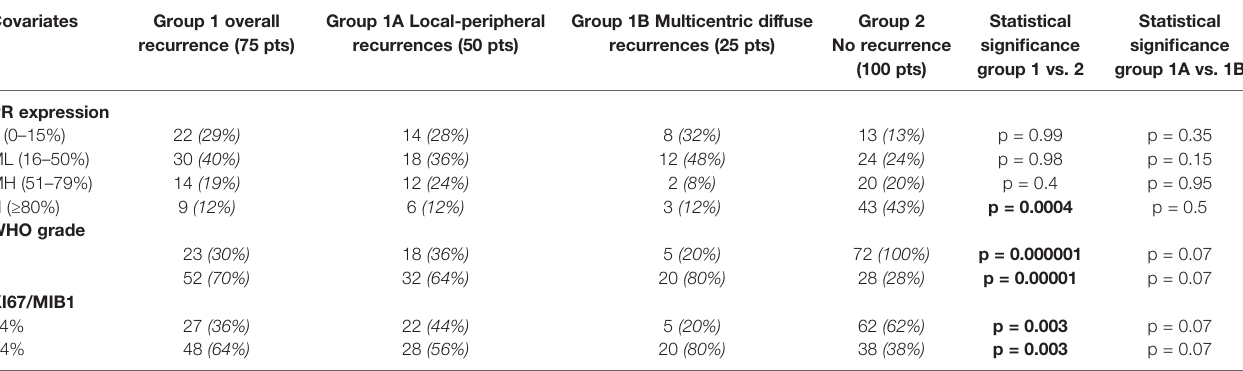
TABLE 7 | PR expression, WHO grade, Ki67/MIB1 at initial surgery and recurrence.